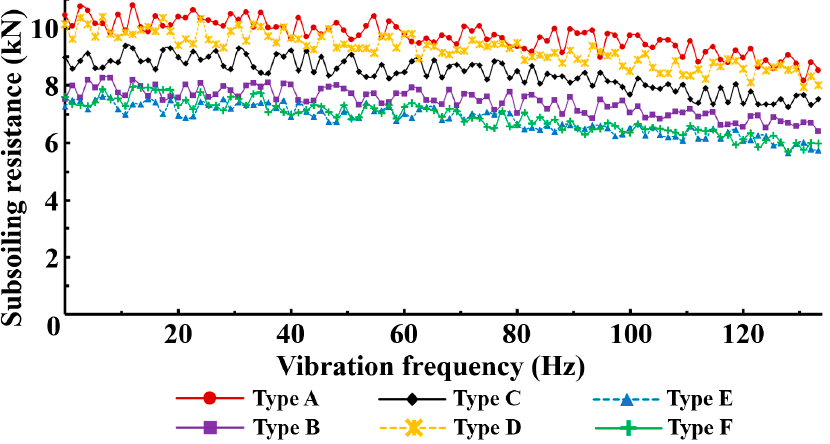
Figure 10. Variation of subsoiling resistance with the vibration frequency of six shovel tips at 5 km/h speed.